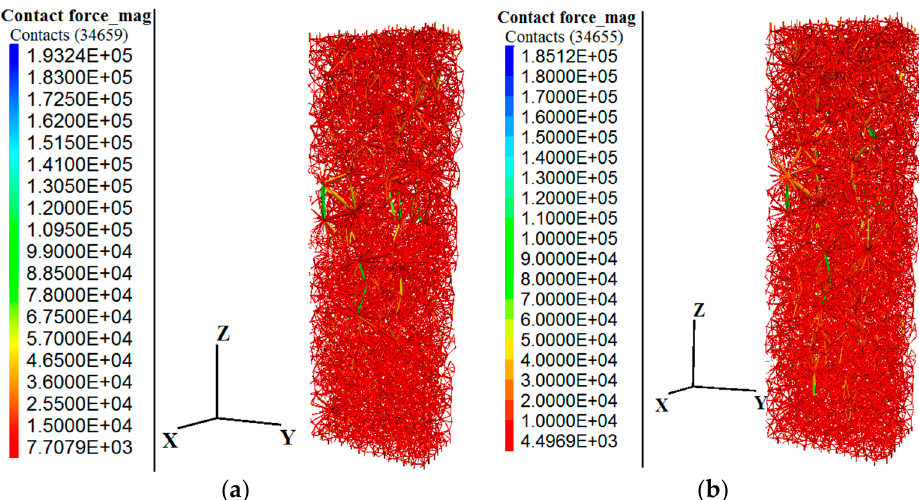
Figure 12. Appl. Sci. 2020 , 10 , x